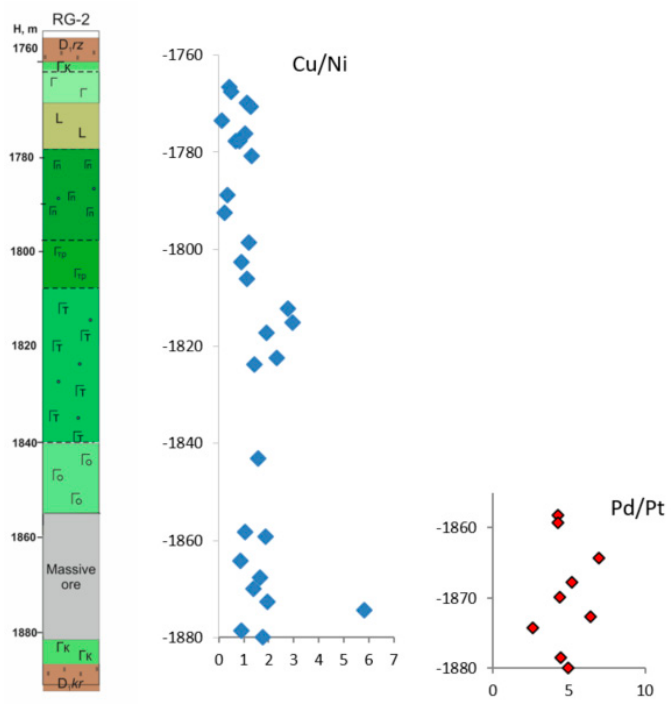
Figure 10. Cu/Ni and Pd/Pt variations in section of borehole RG-2. Table 2. Chemical composition of massive ore (orebody C-5).